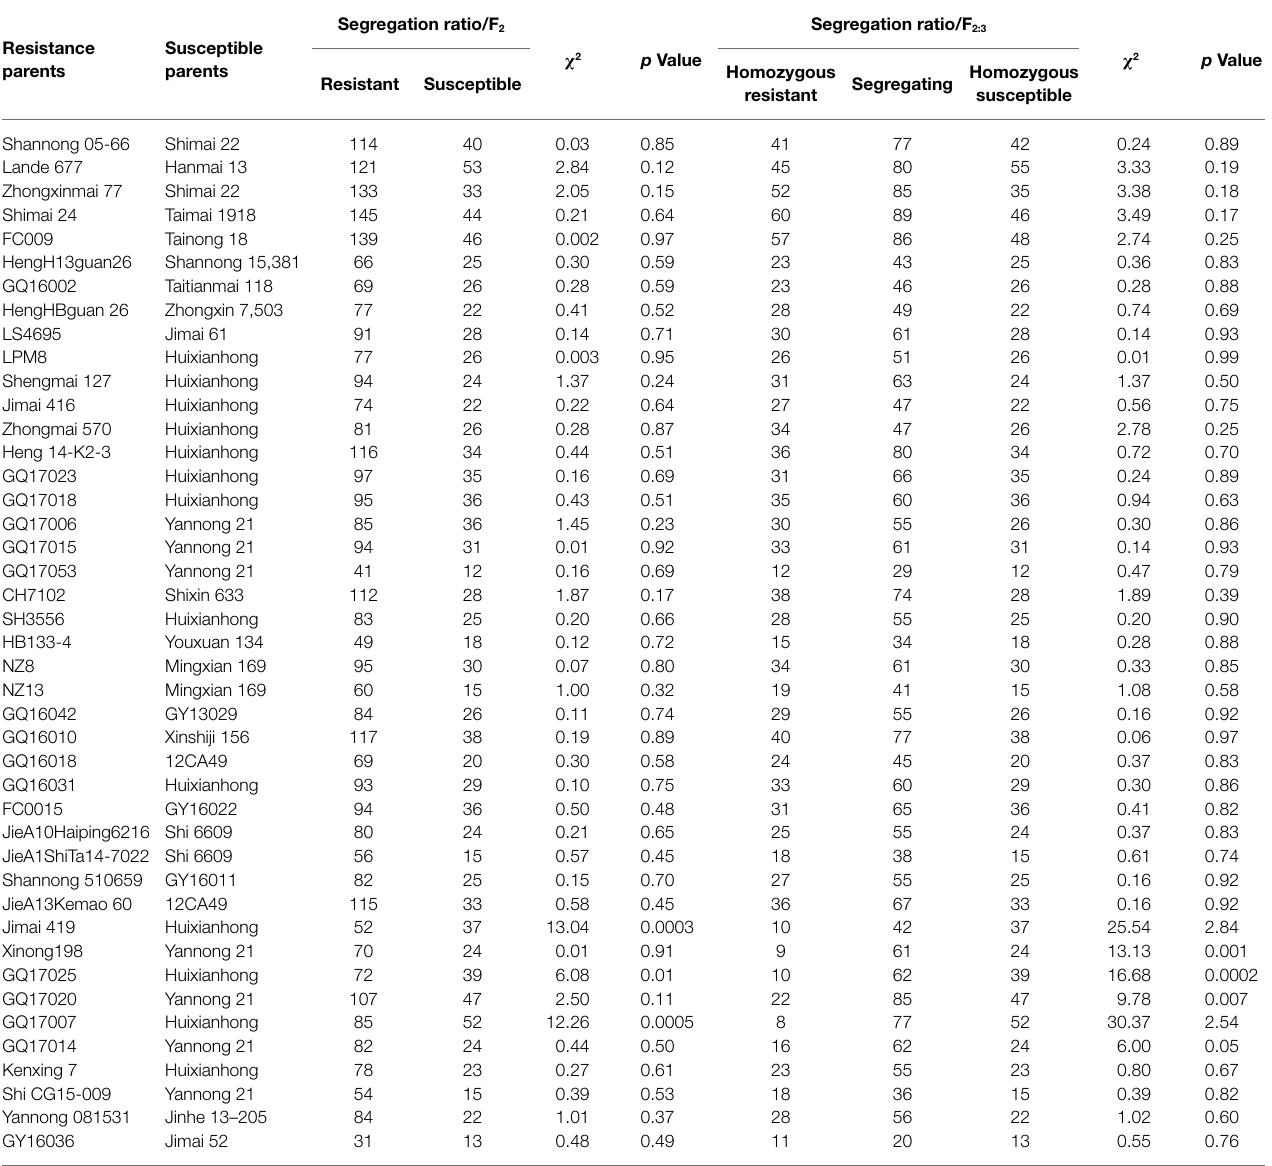
TABLE 1 | Segregation ratios of F 2 and F 2:3 generations of resistant genotypes and different susceptible cultivars following inoculation with Blumeria graminis f. sp. tritici ( Bgt ) isolate E09 at the seedling stage.